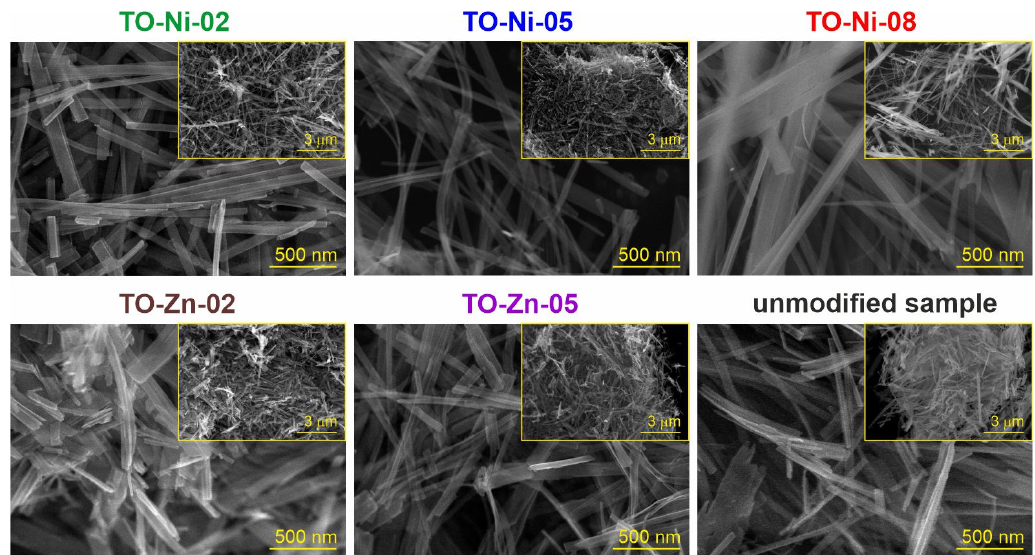
Figure 2. SEM images for titanium dioxide doped with nickel and zinc.